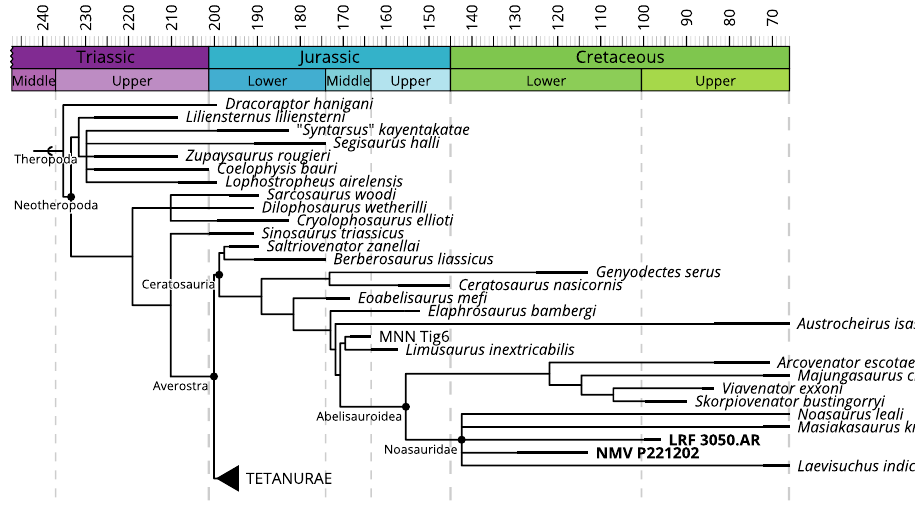
Figure 5. Strict consensus tree of the modified ceratosaurian phylogenetic matrix of Dal Sasso et al . 39 highlighting the phylogenetic positions of the Australian noasaurid specimens LRF 3050.AR and NMV